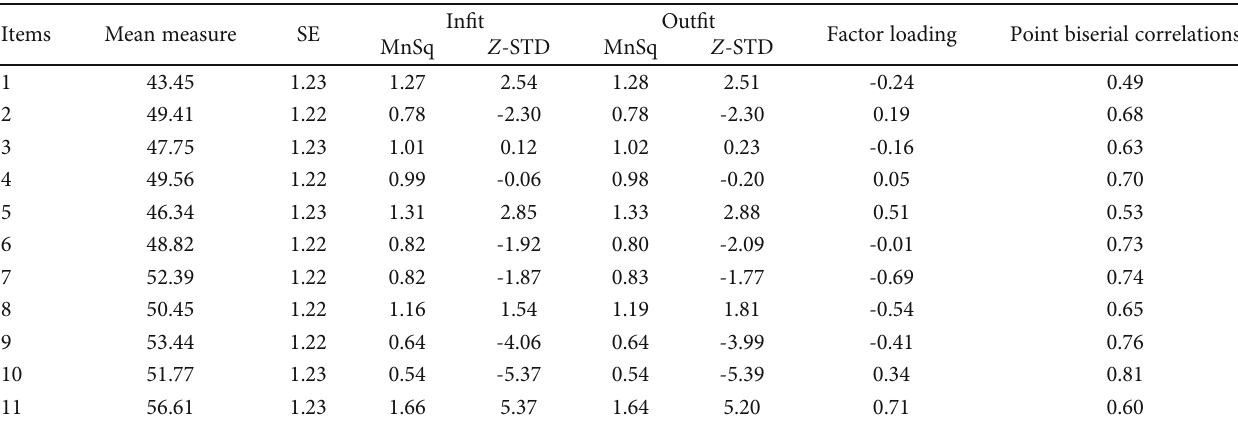
Table 5: Individual item fi t statistics and principal component analysis for all 11 items